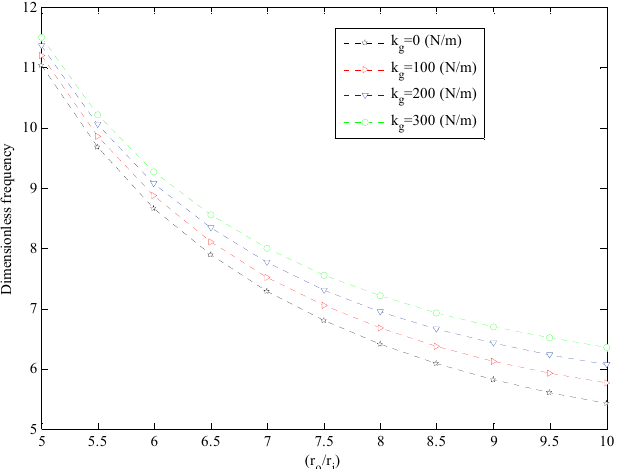
Figure 3. Dimensionless frequency versus radial ratio for different Pasternak coefficients.